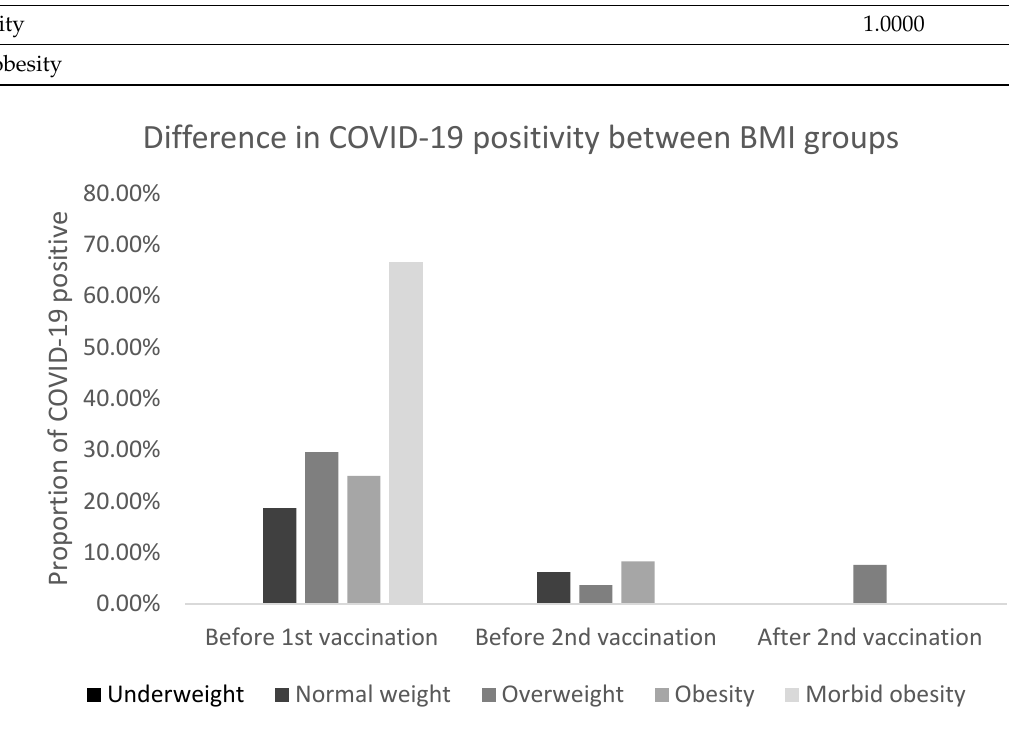
Figure 2. Difference in COVID-19 positivity between body mass index (BMI) groups □ mean ± stand- ard deviation; ◊ median; │ minimum–maximum.